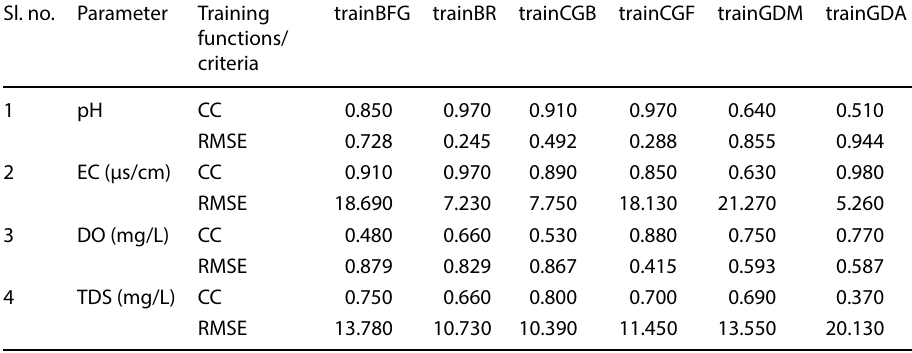
Table 4 CC and RMSE using different training functions for next location data